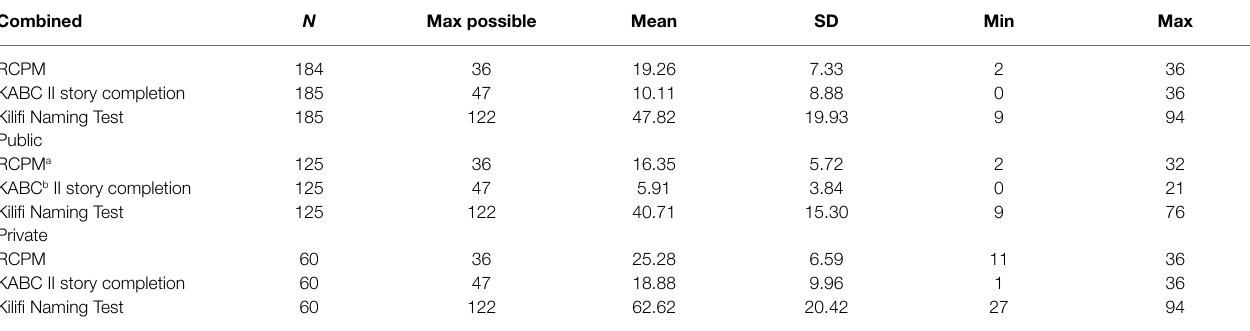
TABLE 2 | Sample variance for